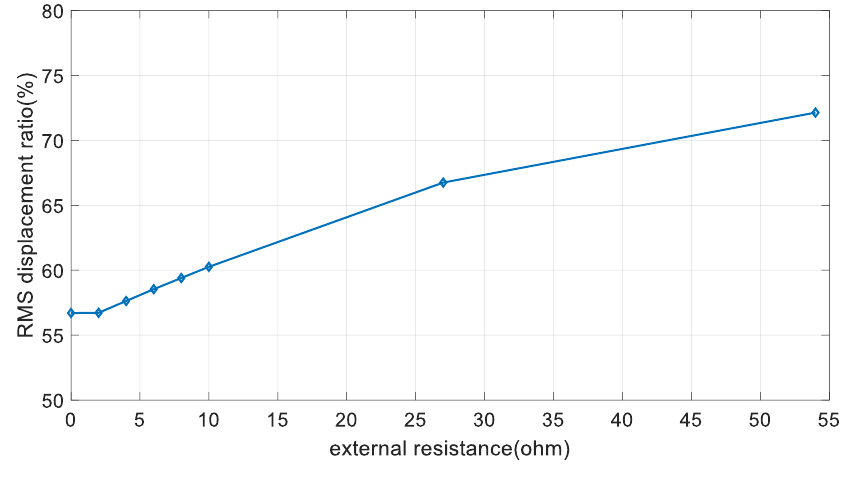
Figure 17. RMS response ratio for various external resistance (mean wind speed of 5 m/s).